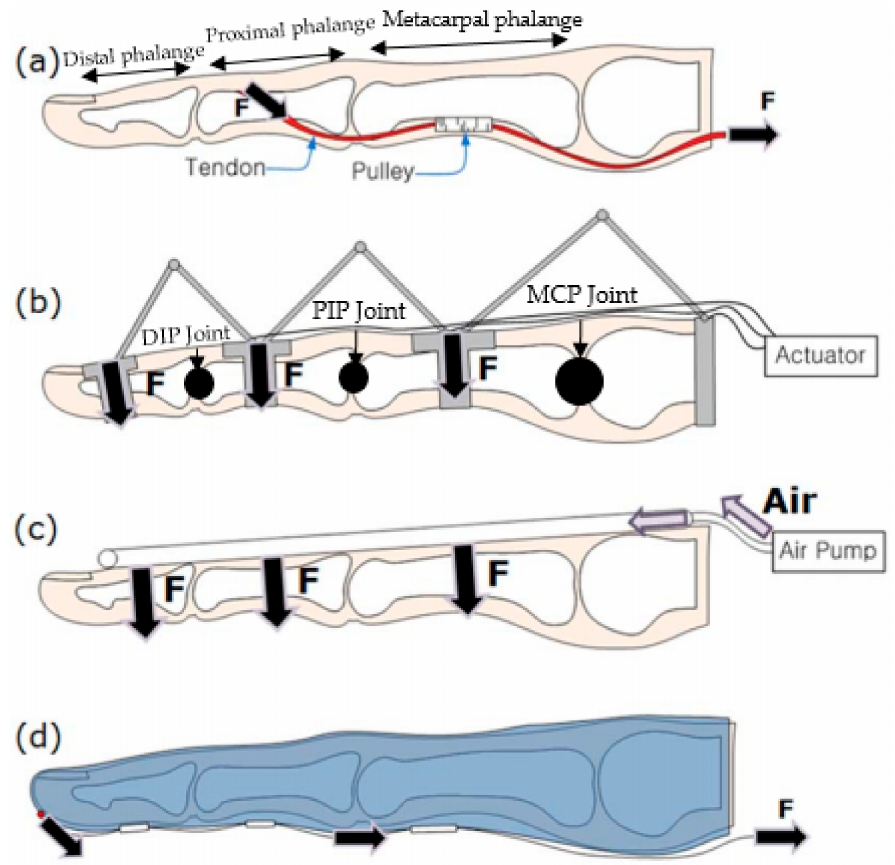
Figure 1. Internal bone structure of a human finger and finger exoskeleton robot, where ‘F’ is the actuation force applied in its respective direction (arrow head). ( a ) The natural skeletal structure of the human finger. ( b ) The rigid joint and link mechanism of a hand exoskeleton; distal (DIP), proximal (PIP) and metacarpal (MCP) interphalangeal joints. ( c ) The pneumatically-actuated hand exoskeleton. ( d ) The tendon/cable–pulley system in a wearable glove. Reprinted and modified with permission from [27], published under the Creative Commons Attribution license (CC BY 2.0)